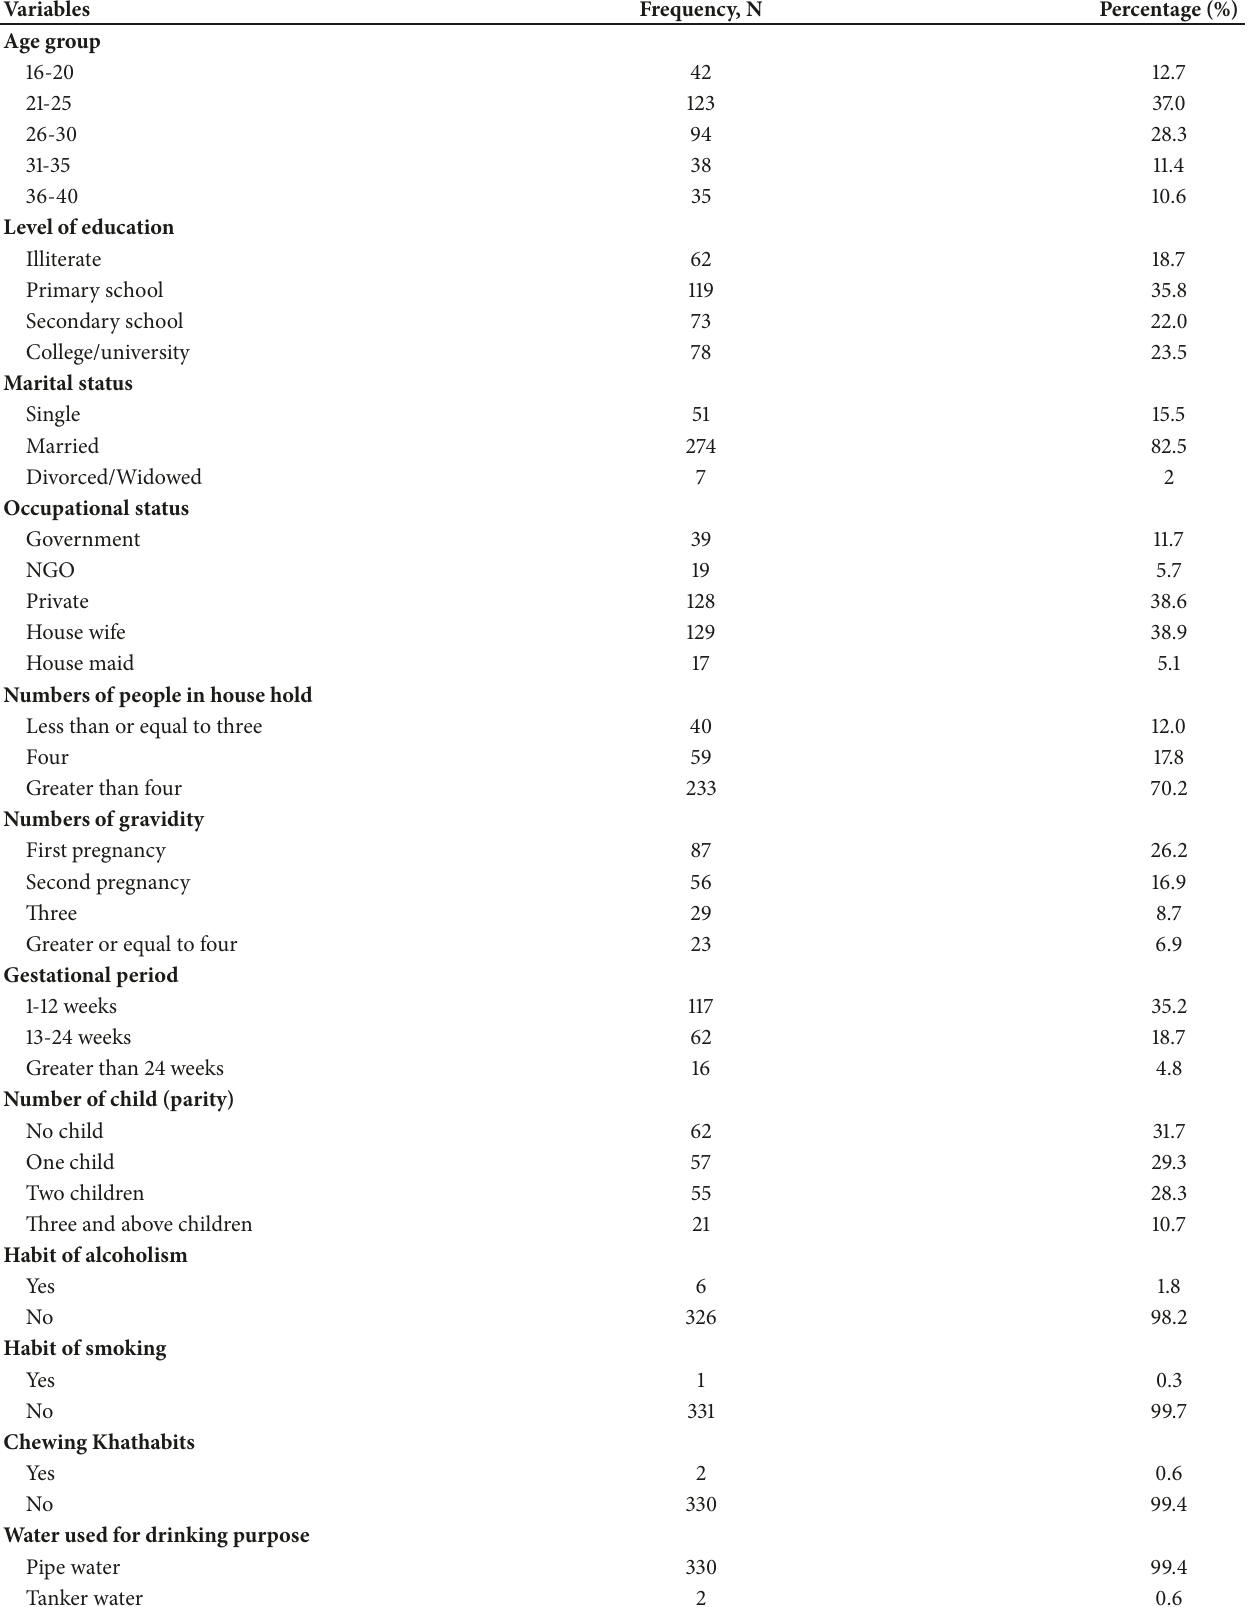
Table 1: sociodemographic characteristics and associated risk factors among women of childbearing ages participated in the study in Addis Ababa, Ethiopia, April to October 2015